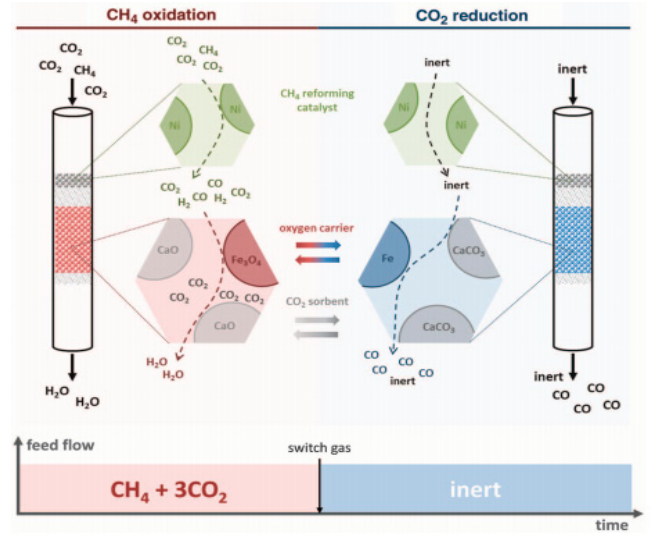
Figure 5. Schematic representation of the “super dry” reforming process [81].